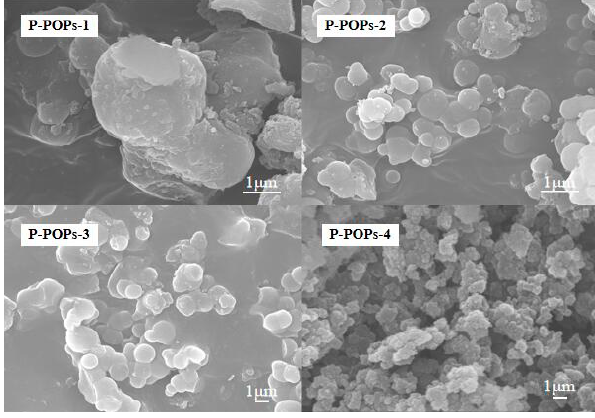
Figure 1. The SEM images of P-POPs-1, P-POPs-2, P-POPs-3 and P-POPs-4.